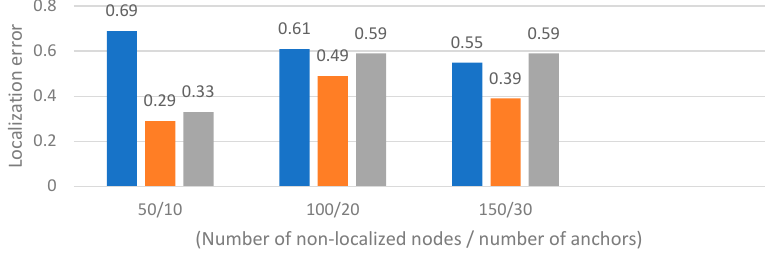
Figure 7. The localization error of the various localization algorithms in multiple UWSN deployments.